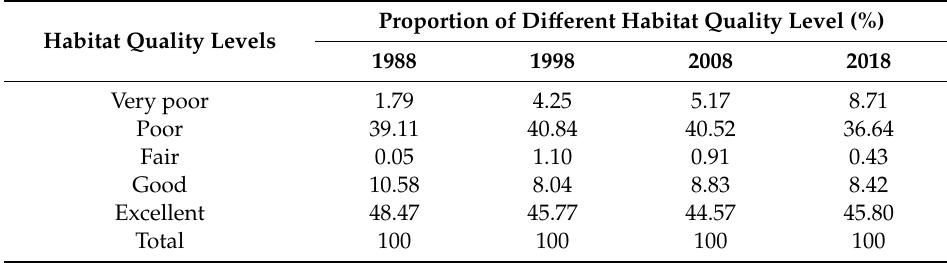
Table 7. The proportion of di ff erent habitat quality levels in the PLEEZ from